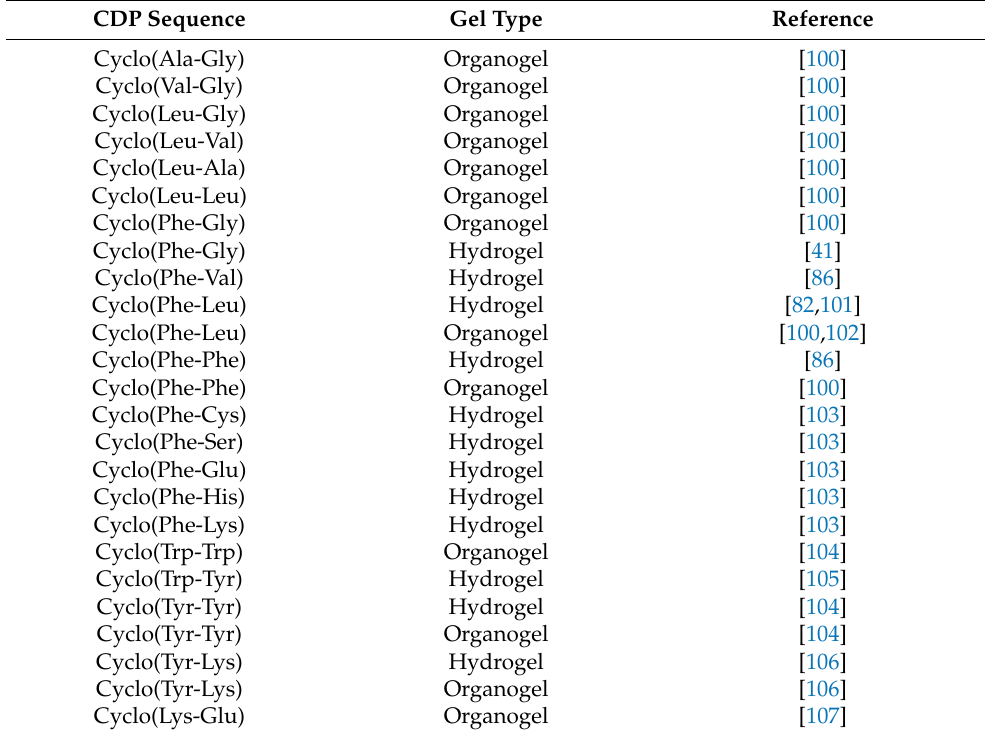
Table 1. Gelling CDPs obtained from unprotected